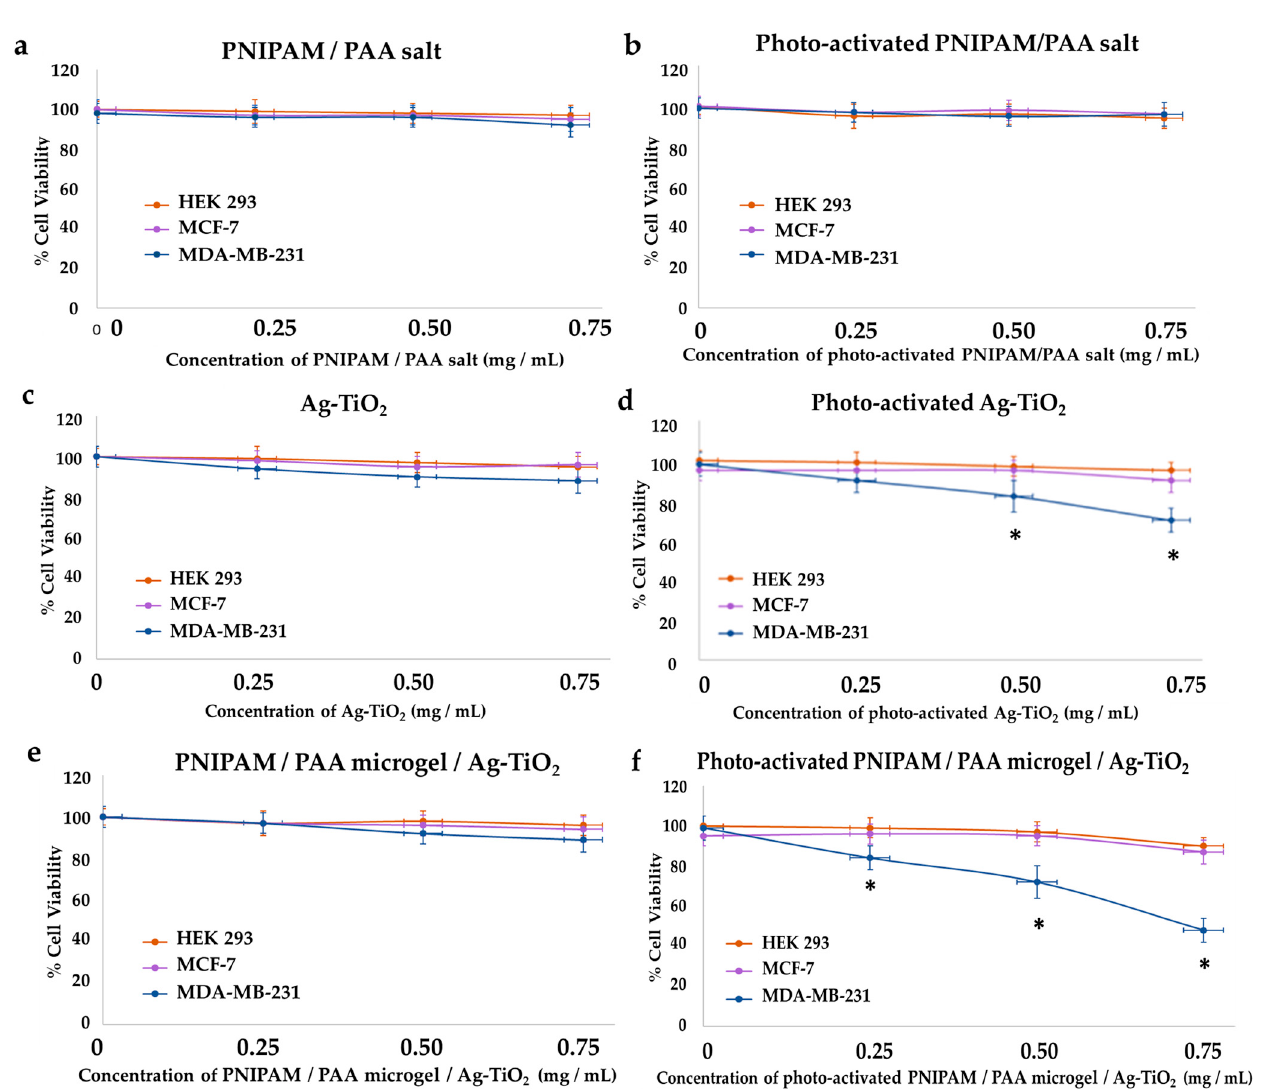
Figure 20. Effect of the produced materials on cell viability. MTT colorimetric assay was employed to estimate the percentage of cell viability of HEK293, MCF-7 and MDA-MB-231 cells in the presence of PNIPAM/PAA salt ( a , b ), Ag-TiO 2 NPs ( c , d ) and PNIPAM/PAA microgel/Ag-TiO 2 NPs ( e , f ) in increasing concentrations and also before and after photoactivation with visible light. Photoactivated Ag-TiO 2 NPs gradually decreased the cell viability of MDA-MB-231 cells, and this phenomenon was more intense in the presence of PNIPAM/PAA microgel/Ag-TiO 2 NPs. * p < 0.05 vs. negative control, through the Kruskal–Wallis nonparametric test. The obtained data represent means ± standard deviation from four experiments.